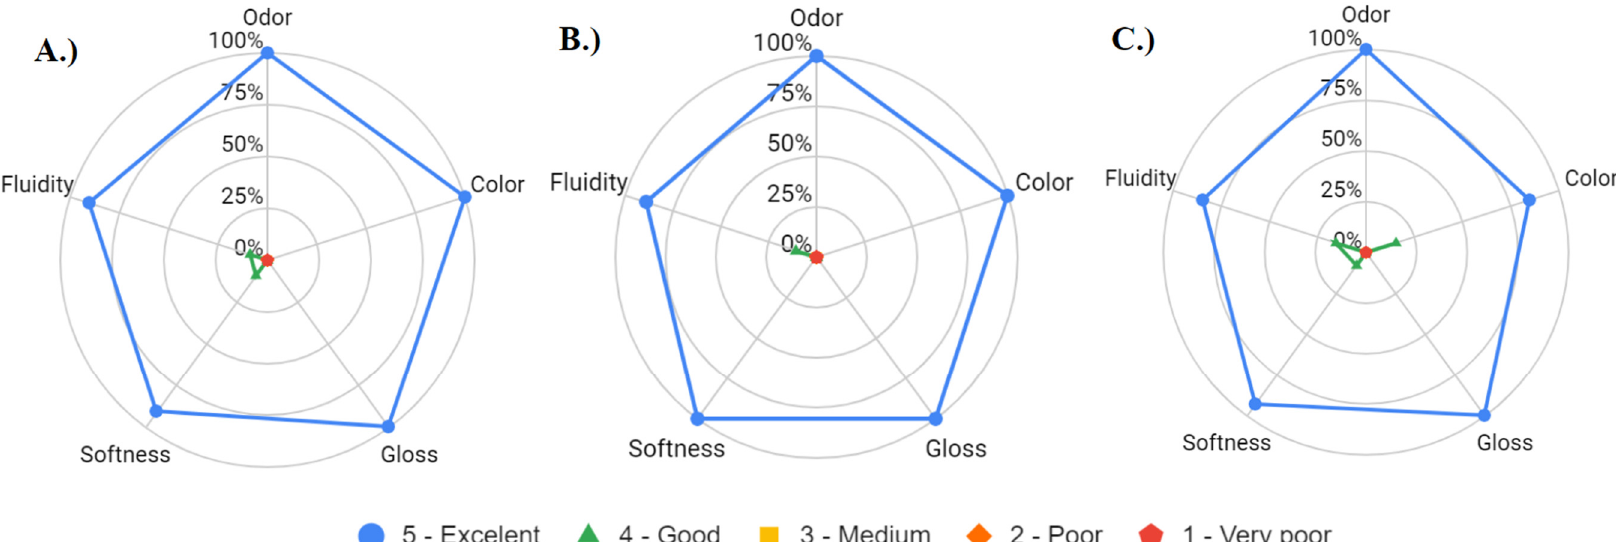
Figure 1. Evaluation of the formulations’ characteristics. The attributes of the three formulas were evaluated by the 33 subjects who graded them according to their perception. The attributes evaluated were: odor, color, gloss, softness, and fluidity. The possible grades were 5—excellent, 4—good, 3—medium, 2—poor, and 1—very poor. ( A ). Evaluation of formula A, placebo; ( B ). evaluation of formula B, containing 5% of VC-IP ® ; ( C ). evaluation of formula C, containing 15% of VC-IP ® . The more spread out an attribute is in the area of the graphic, the higher the percentage of answers that it received. The grades that do not appear in the graphs were not attributed to any of the characteristics. The percentage is related to the number of subjects, with the total number of subjects—33 women—being 100%. Source: from the authors.